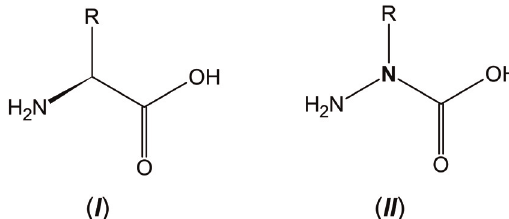
Fig. 1. Structure of α -amino acid ( I ) and α -aza-amino acid ( II ).